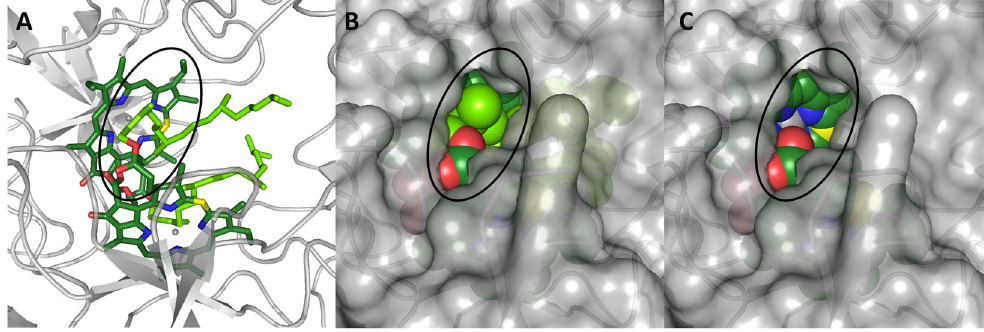
Figure 6. Close look of the structure of L. virginicum WSCP 11 , focused on the solvent-accessible part of the Chl molecule in the cavity (highlighted with a black ellipse). The same view is reported in the three panels, with the polypeptide chains in gray cartoons (protein surface in transparent gray in panels B and C ) and the Chls a ( A and B ) or Chlides a ( C ) constituting a dimer shown either in sticks ( A ) or in spheres ( B and C ). Atoms colors as in Fig.